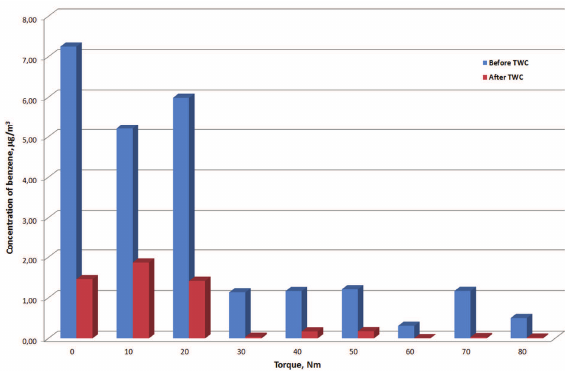
Figure 5 comparison of the concentrations before and after catalyst reactor on the example of benzene is shown.